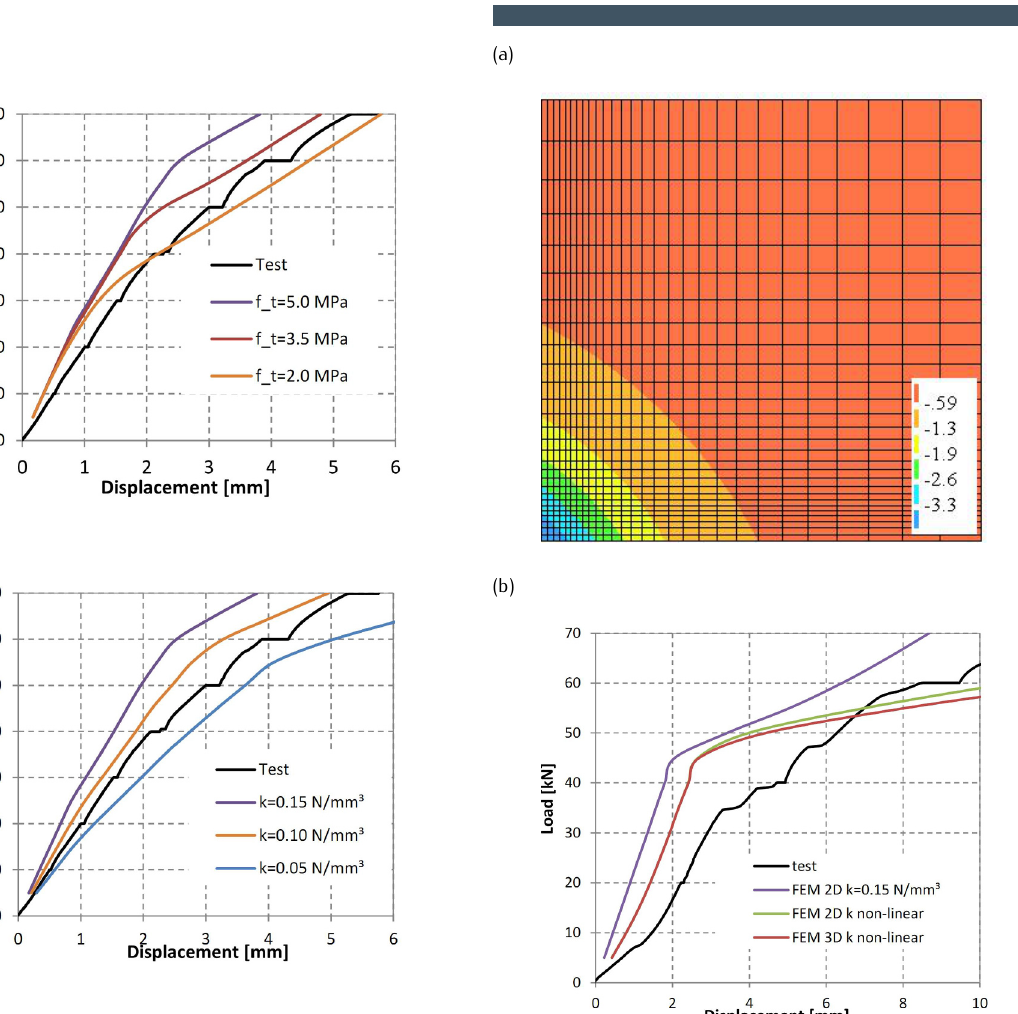
Figure 19. Edge load, effect of varying the (a) Tensile strength, (b) Subgrade stiffness. in the figure at a load level of 40 kN. The contour lines